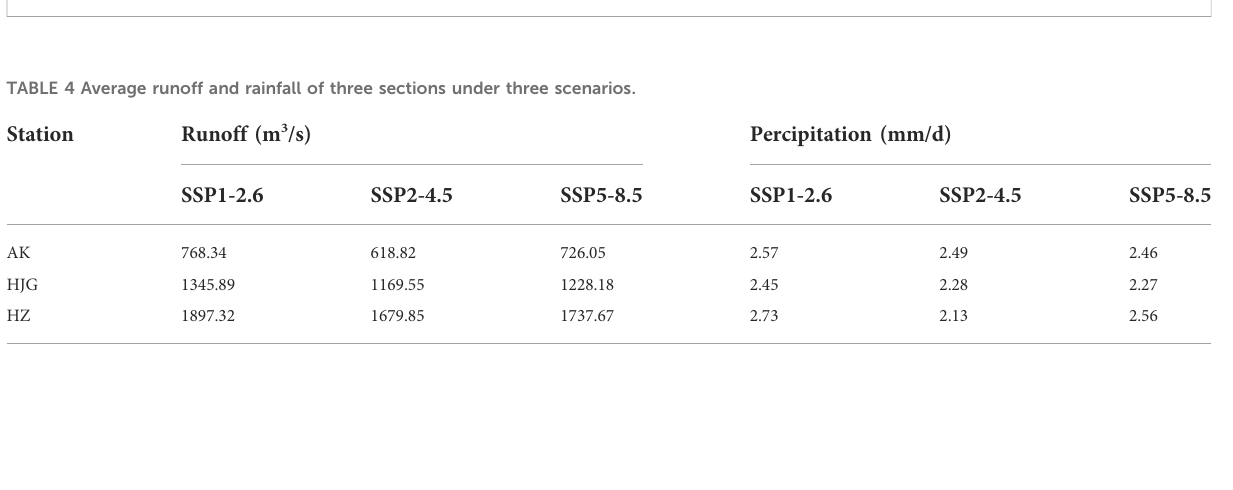
FIGURE 13 Differenceofmonthlyrunoffproportionofthreesectionsunderdifferentscenariosrelativetohistoricalperiod(%). (A – C) arethemonthlyrunoff distribution of AK, HJG and HZ under SSP1-2.6, SSP2-4.5 and SSP5-8.5 compared with the historical period.